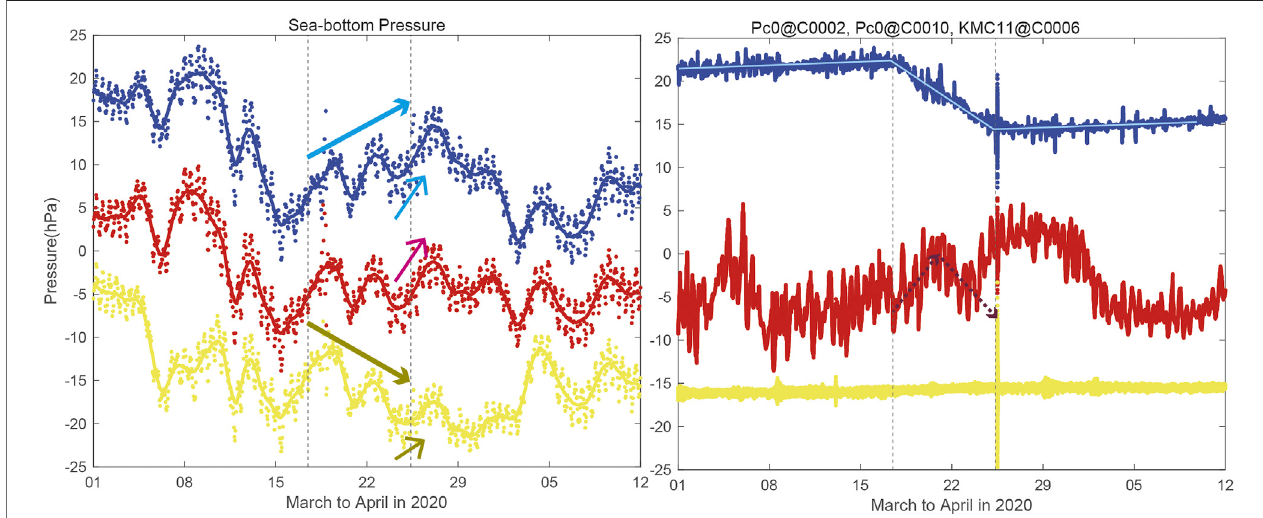
FIGURE11|(A) Timehistoryofdetidedpressurechangesintegratedfromatmospheretosea fl ooronthebasisofJCOPE-TDAwiththesamecolorsas Figure2A . Bold curves show moving average for 25 h. Vertical lines show the onset and termination time of the SSE in March 2020. Long and short arrows represent the trend change between the onset and termination of the SSE and short-term oscillation at the termination of the SSE. (B) Time history of pore pressure for corresponding time span.DottedarrowsshowthecrustaldeformationcomponentofporepressureonthebasisofmodelsA-1andA-2+estimatedbyAriyoshietal.(2021).Lightcyan lines show the regression analysis estimated by Ariyoshi et al.